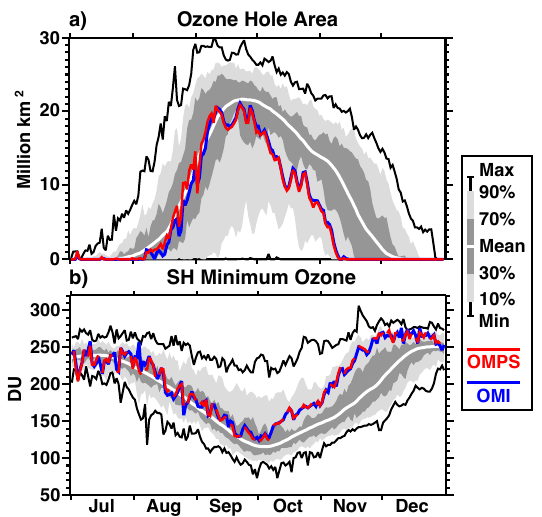
Fig. 5. (a) Ozone hole area and (b) minimum ozone for OMI (blue) and OMPS TC-NM (red) for 2012. Also shown are the daily clima- tological distributions for the period 1979–2011: the minimum and maximum (black lines), the 10–90 percentiles (light gray region), the 30–70 percentiles (dark gray region), and the mean (thick white